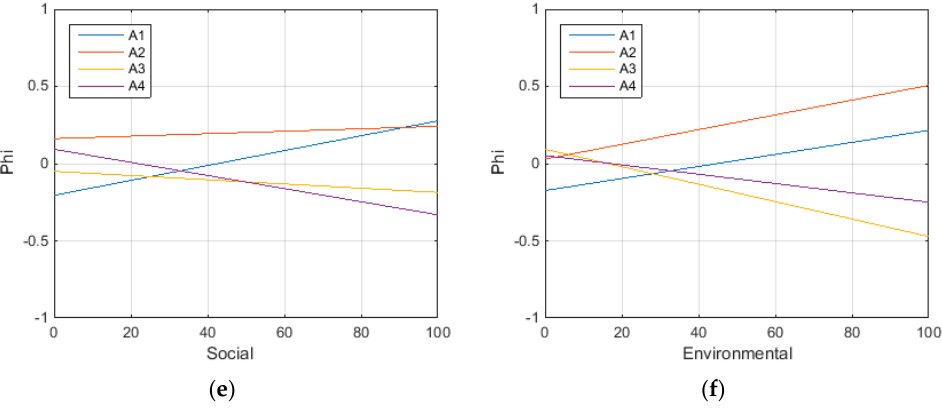
Figure 10. Plots of the solution sensitivity to the changes of weights of groups of criteria: ( a ) economic—PROSA; ( b ) social—PROSA; ( c ) environmental—PROSA; ( d ) economic—PROMETHEE; ( e ) social—PROMETHEE; ( f )